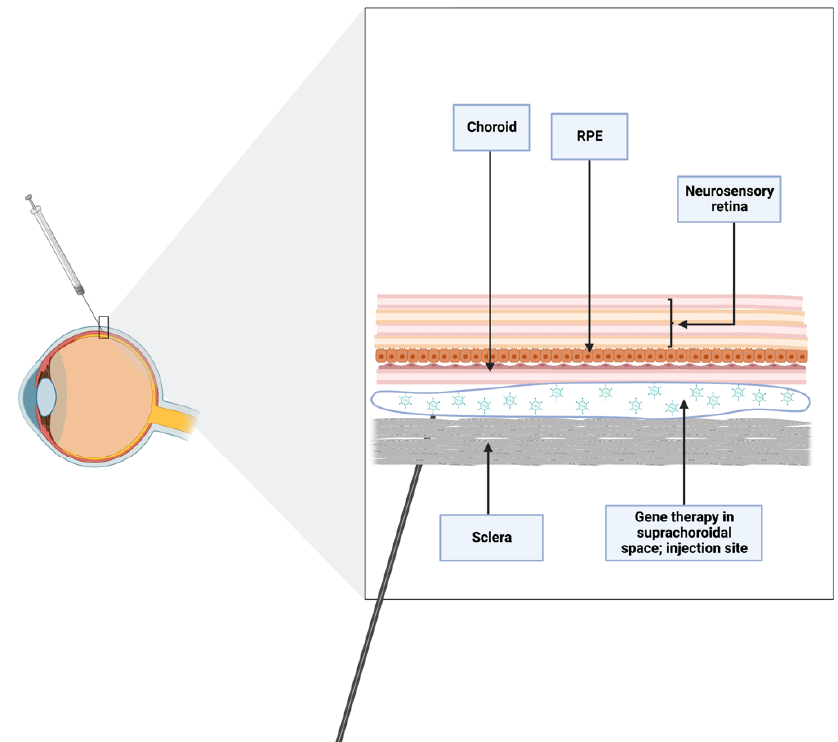
Figure 8. Schematic of suprachoroidal injection. Needles reaching nanodimensions are optimal for accessing suprachoroidal space, avoiding iatrogenic trauma in the vitreoretinal space.